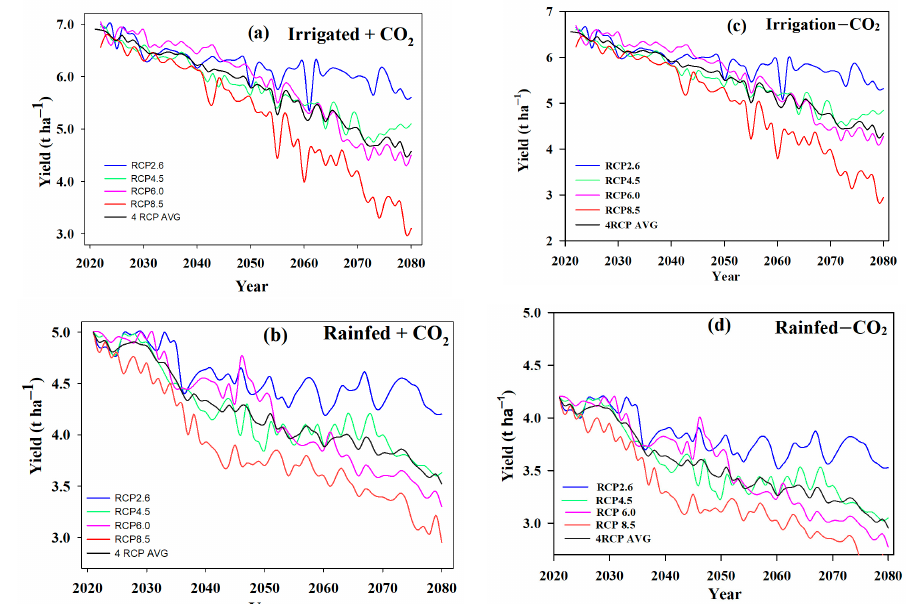
Figure 5. Temporal evolutions of the maize crop yields, with and without increased CO 2. ( a ) Irrigated + CO 2